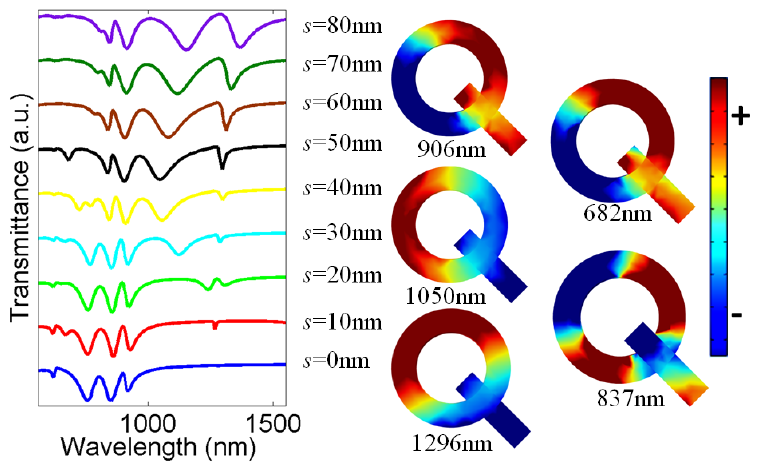
Figure 4. Transmittance spectra of ring/rod metasurface for different values of s . Inset shows surface charge distributions at s = 50 nm. Table 2. Q ‐ factor and FoM values around Fano resonances